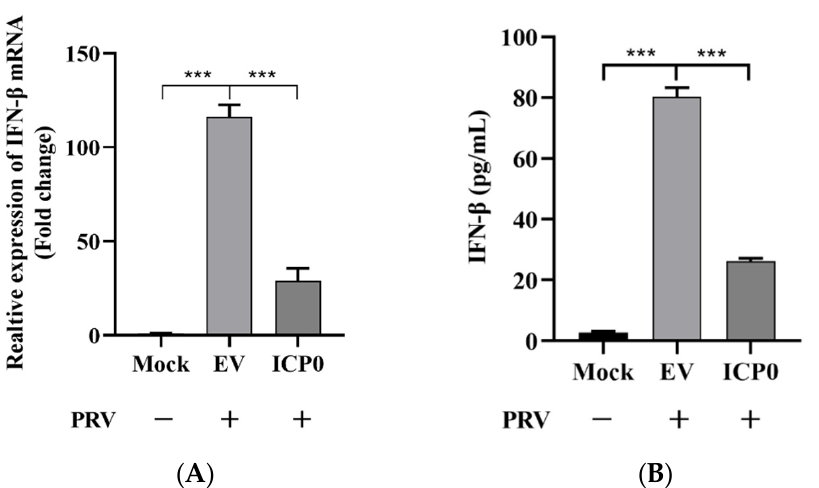
Figure 7. ICP0 protein promotes PRV proliferation via decreasing IFN- β production. ( A ) PK15 cells were transfected with pCMV-Myc and Myc-ICP0 plasmids. Then, cells were infected with PRV. Cellular RNA was extracted, and RT-qPCR was performed to detect IFN- β mRNA transcription. ( B ) PK15 cells were transfected with pCMV-Myc and Myc-ICP0 plasmids. Then, cells were infected with PRV. Cell culture supernatant was collected. The secretion expression of IFN- β was detected using ELISA. Data are shown as mean ± SD from three independent experiments. Comparison be- tween two groups was evaluated by unpaired Student’s t -test. *** p < 0.001.